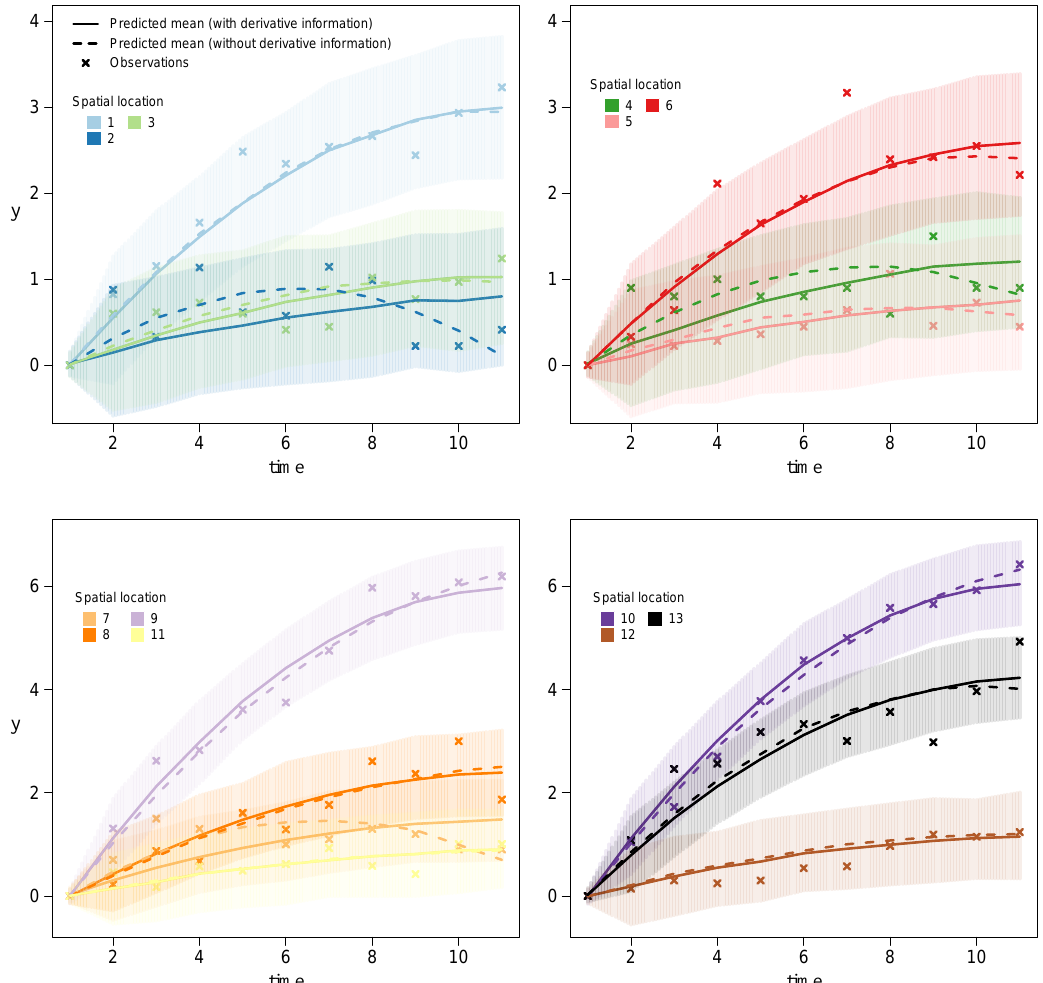
Figure 5. Predictive distributions (means and 95% pointwise credible intervals) of the regular process with and without derivative information plotted as functions of time, and for specific sampling spatial locations. The actual data y have also been plotted as